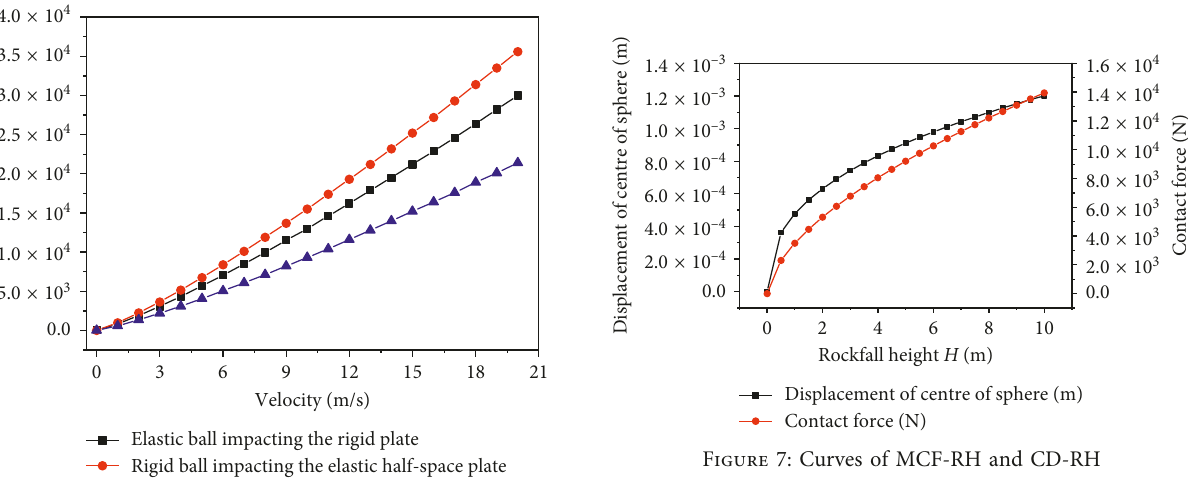
Figure 6: Curves of MCF-CD under different condition.